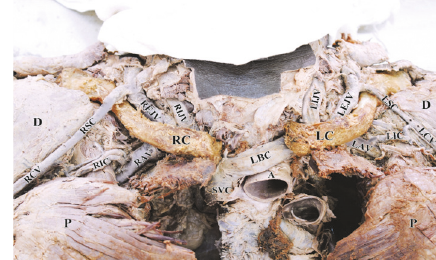
Figure 1: Dissected body with the clavicles (RC and LC) in situ, right and left internal jugular vein (RIJV and LIJV), right and left external jugular vein (REJV and LEJV), right and left supraclavicular (RSC and LSC) branches of cephalic vein, right and left cephalic vein (RCV and LCV), right and left infraclavicular (RIC and LIC) branch of cephalic vein, right and left axillary veins (RAV and LAV), left brachiocephalic vein (LBC), superior vena cava (SVC), aorta (A), deltoid muscle (D), and pectoral major muscle (P).